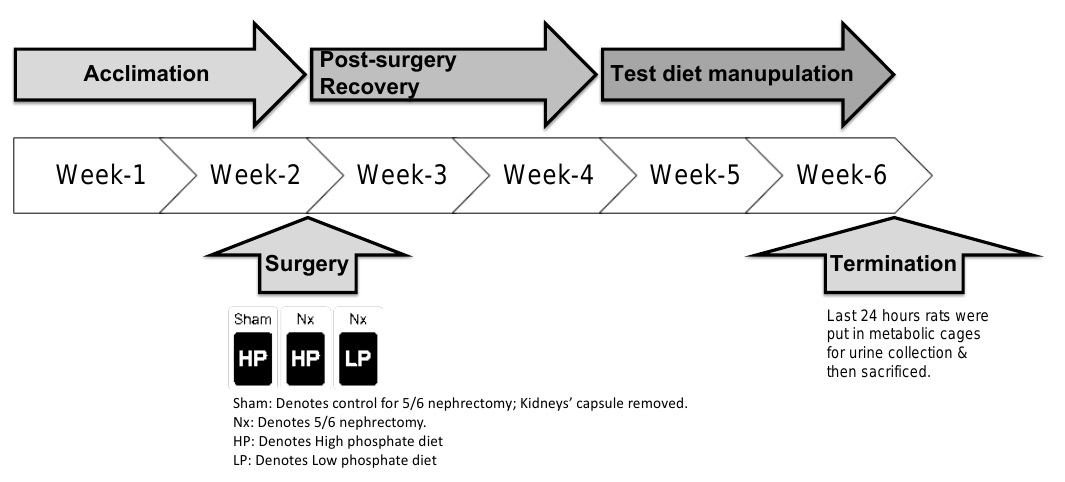
Scheme 1. Schematic overview of in vivo study design.